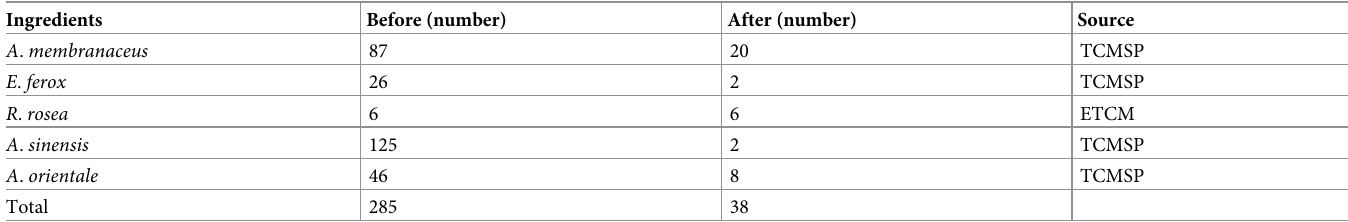
Table 1. Significant herbal components of Yishen decoction after screening. Ingredients